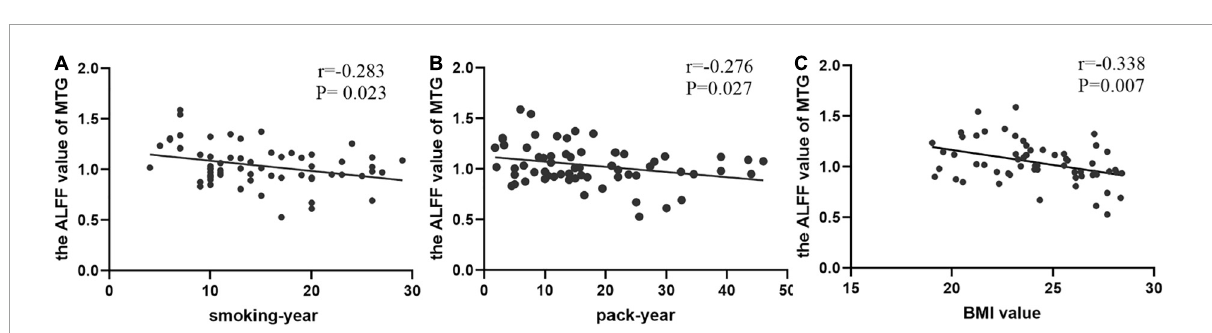
FIGURE3 The correlations between the value of ALFF in the middle temporal gyrus (MTG) and clinical data. (A) In smokers, smoking-year was negatively correlated with the value of MTG (Spearman’s correlation, r = –0.283, p = 0.023); (B) pack-year was negatively correlated with the value of MTG (Spearman’s correlation, r = –0.276, p = 0.027); (C) BMI value was negatively correlated with the value of MTG (Spearman’s correlation, r = –0.338, p =